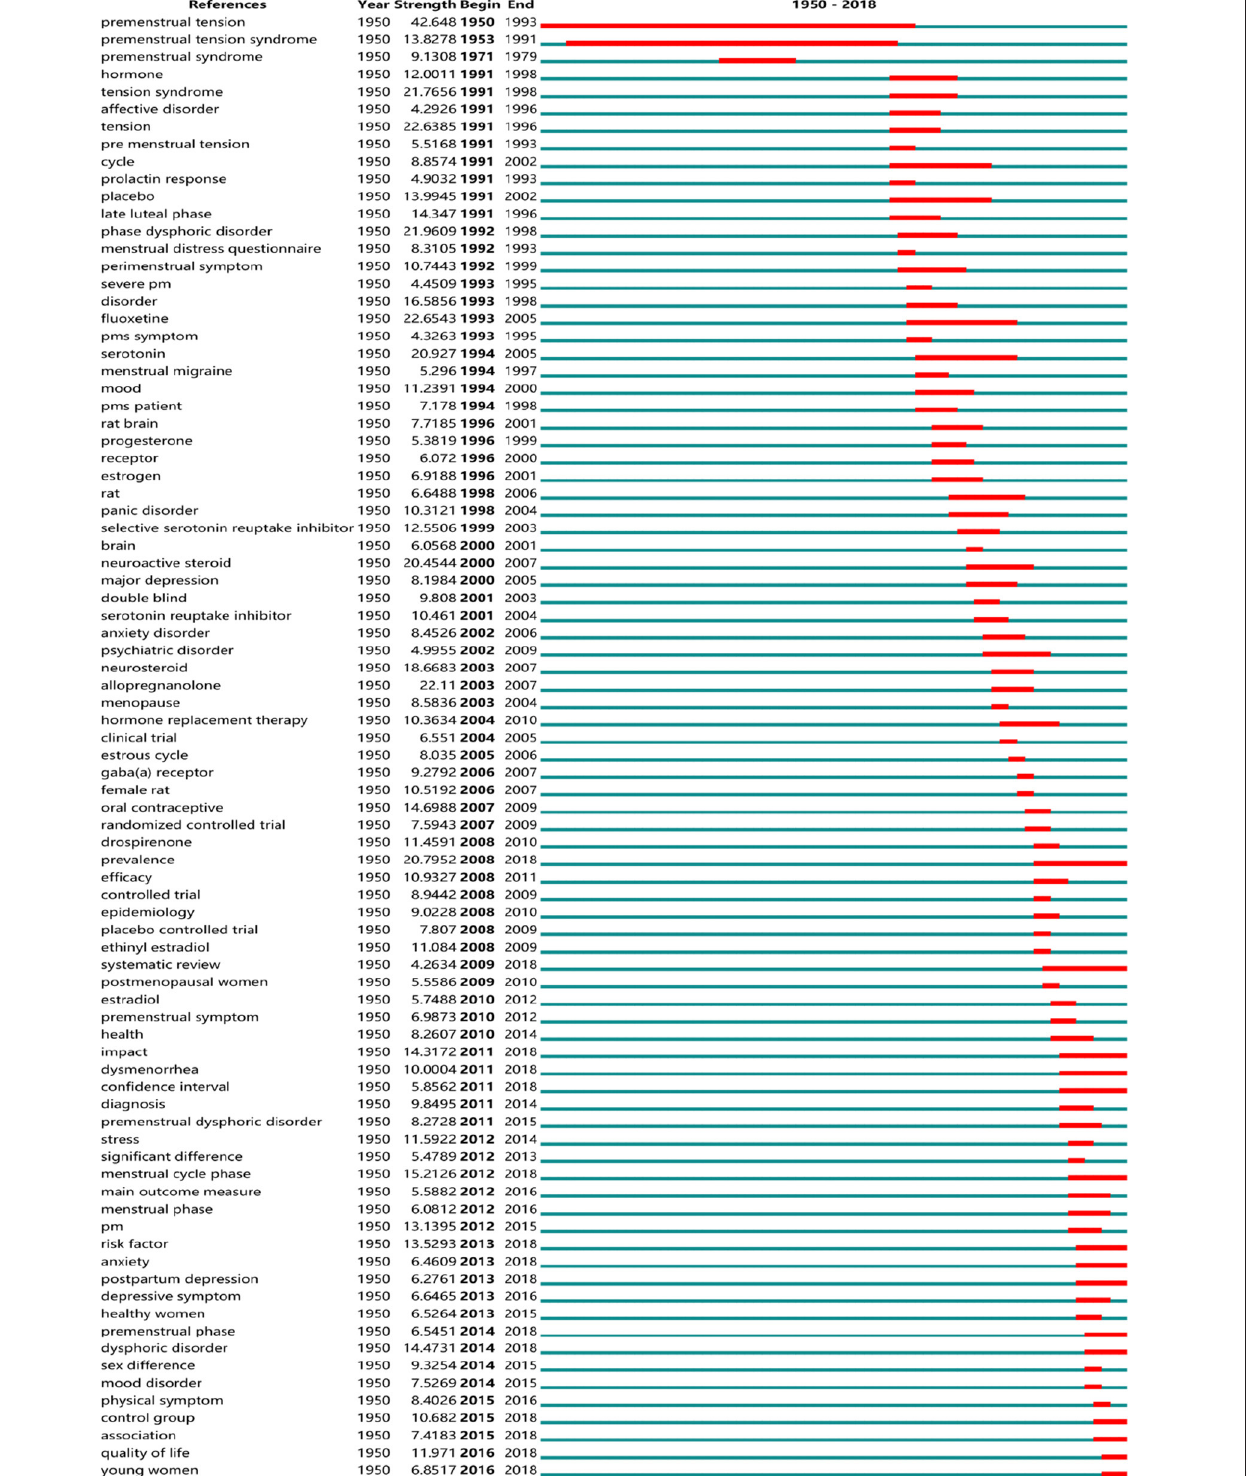
Frontiers in Public Health |